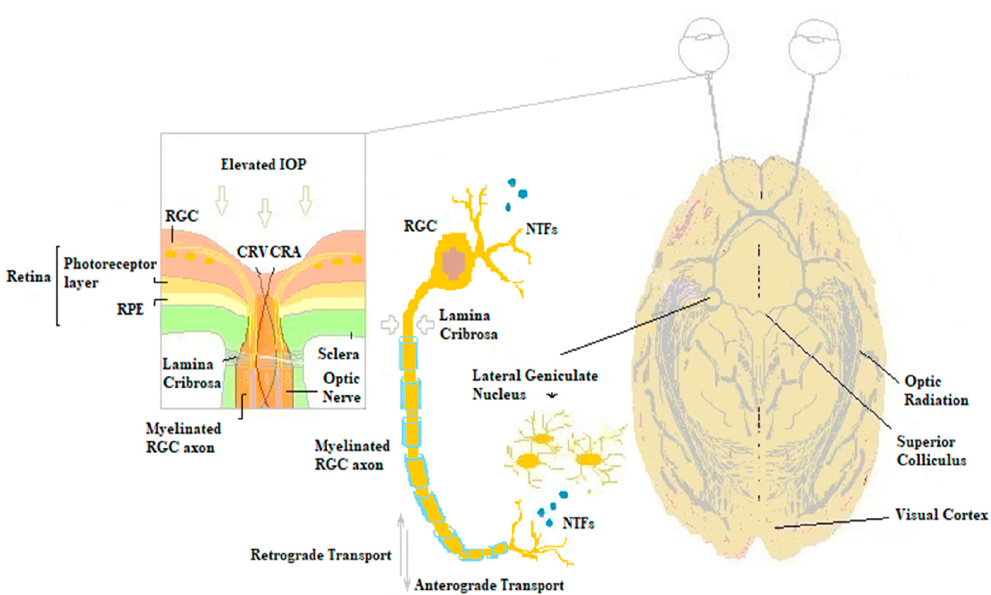
Figure 1. Biochemical mechanisms of glaucomatous damage. The elevated intraocular pressure (IOP) at the lamina cribrosa is responsible for the blockage of the retrograde axonal transport of NTs from the lateral geniculate nucleus of the thalamus to retinal ganglion cells. The deprivation of neuronal trophism in turn triggers apoptotic ganglion cells death, resulting in decreased local NTFs processing and impaired anterograde transportation along RGCs axons. RGC, retinal ganglion cell; CRV, central retinal vein; CRA, central retinal artery; NTFs, neurotrophic factors; RPE, retinal pigment epithelium.